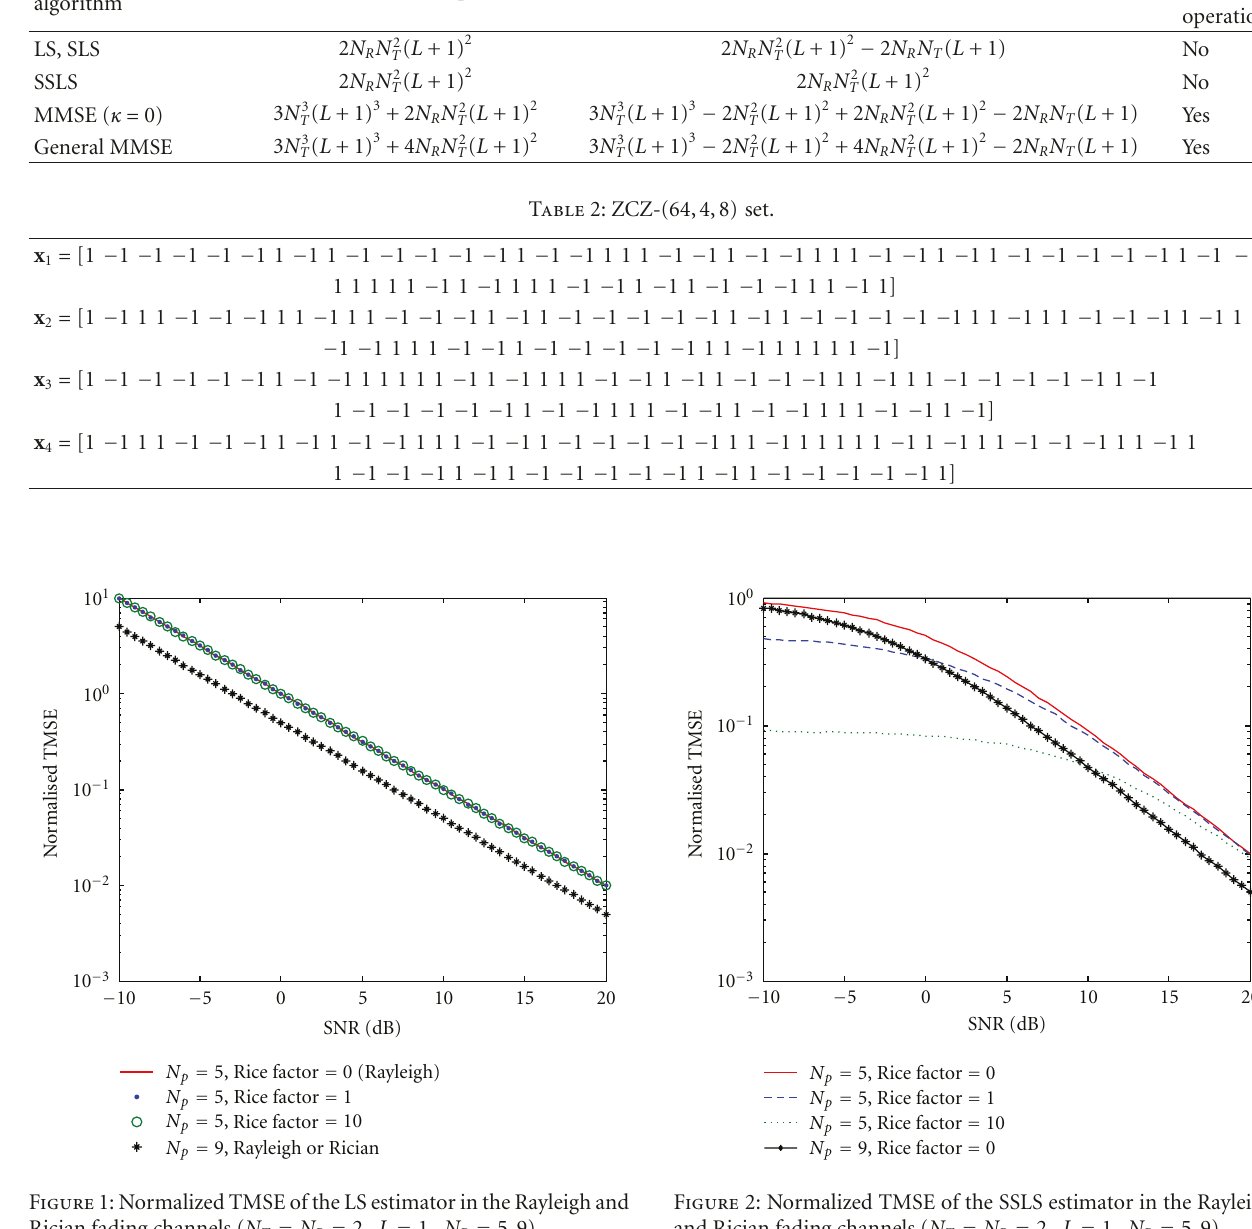
Table 1: Computational complexity of the LS-based and MMSE channel estimators ( N P = N T ( L + 1) + L ). Channel estimation